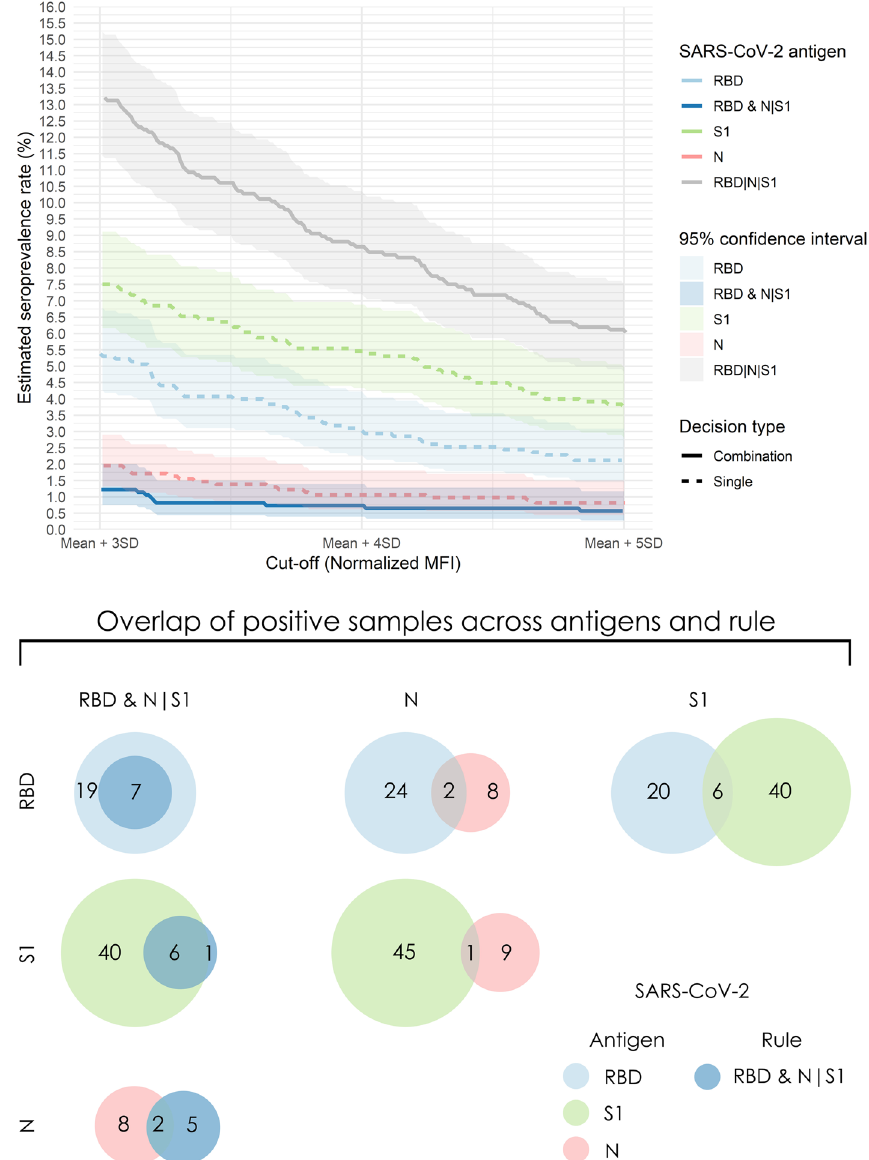
Figure 3. SARS-CoV-2 seroprevalence analysis in 1225 blood donors using the in-house single-antigen readouts or the RBD & N|S1 and RBD|N|S1 multi-antigen rules. ( A ) SARS-CoV-2 estimated seroprevalence rates are presented in the y axis, while different cut-off values are presented in the x axis . The cut-off values for each antigen are based on the distribution of normalized MFI of negative samples ( B ) Consensus in detection of SARS-CoV-2 positive individuals using single and multiple-antigen readouts. A stringent cut-off of Mean + 5 SD is used for